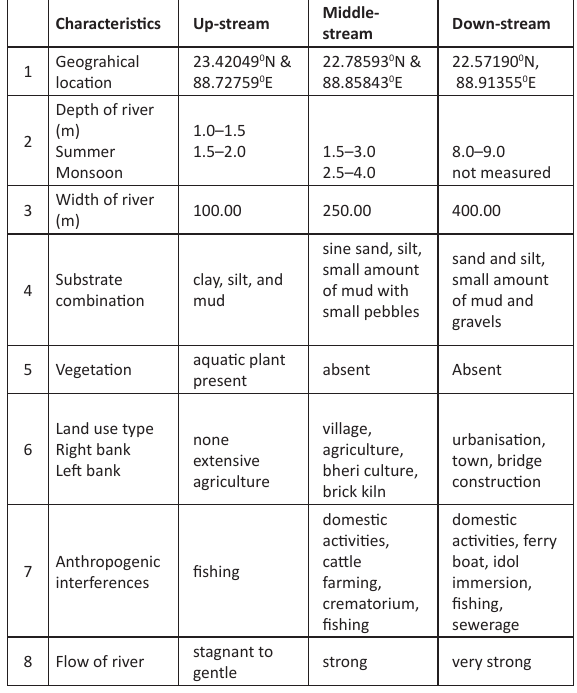
Table 1. Geographical and physical characteristics of three sites of river Ichamati